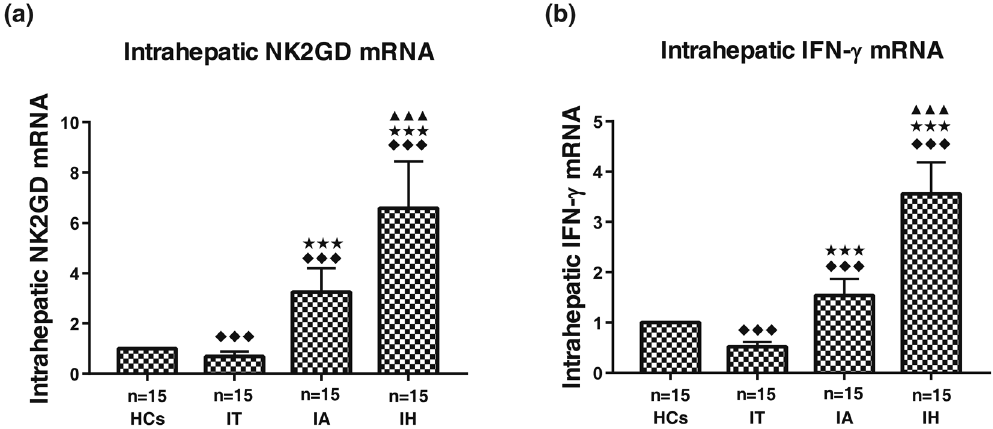
Figure 2. Intrahepatic expression of NKG2D mRNA ( a ) and IFN- γ mRNA ( b ). HCs, healthy controls (the relative expression were defined as 1.00); IT, chronic HBV carriers; IA, CHB patients; IH, HBV-ACLF. Nemenyi test following Kruskal-Wallis H test were used for comparing mRNA expressions of NKG2D and IFN- γ between two groups. Compared with HCs group, ◆◆◆ P < 0.01; Compared with IT group, ★★★ P < 0.01; Compared with IA group, ▲▲▲ P <